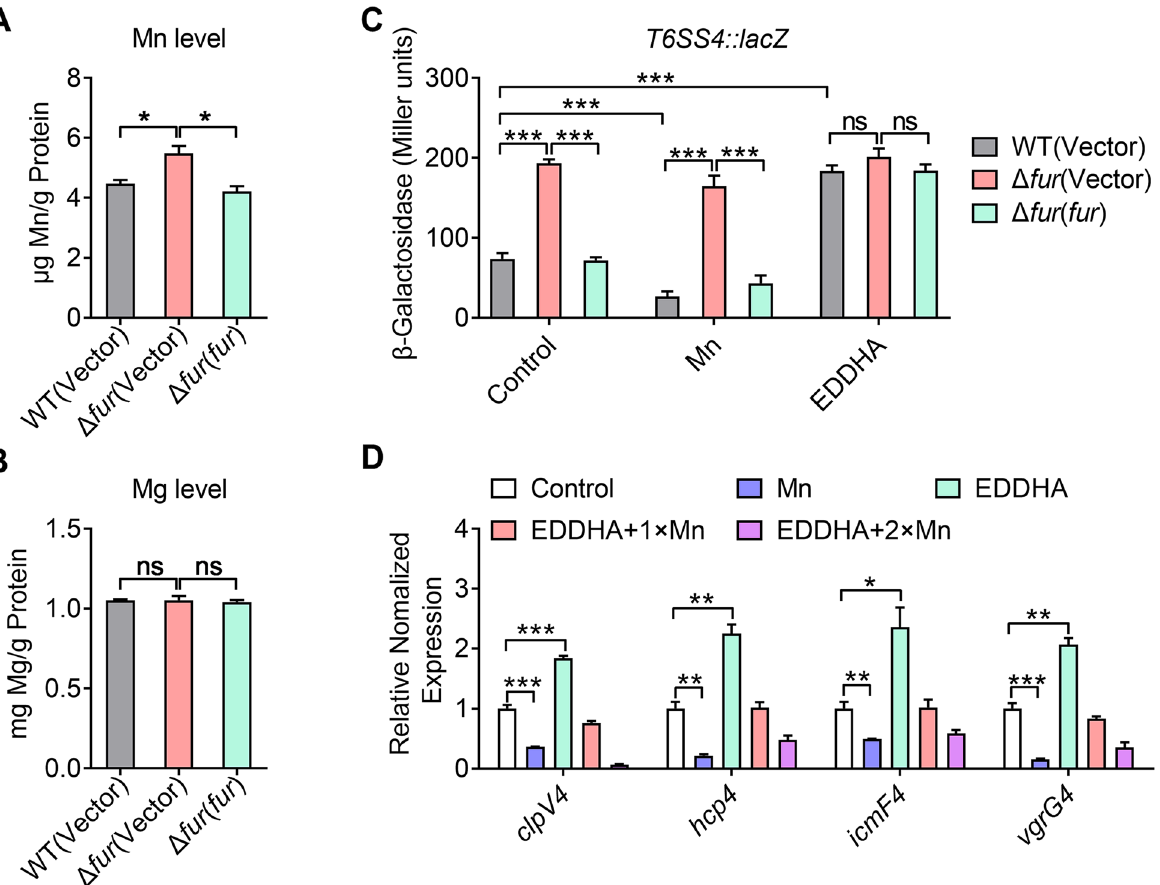
Fig. 3 Fur-mediated expression of T6SS4 responds to Mn 2 + concentration. A‑B The Δ fur mutant accumulates intracellular Mn 2 + . Intracellular manganese and magnesium were measured by ICP-MS in the Y. pseudotuberculosis strains grown to the end of logarithmic phase in YLB medium. C Fur-mediated expression of T6SS4 responds to different Mn 2 + concentrations. β-galactosidase analysis of T6SS4 promoter activities was performed in Y. pseudotuberculosis strains grown to stationary phase in YLB medium with or without 100 μM EDDHA and 100 μM Mn 2 + . D T6SS4 expression is induced by low Mn 2 + conditions. qRT-PCR analysis of mRNA levels of T6SS4 in the Y. pseudotuberculosis WT strain grown to mid-exponential